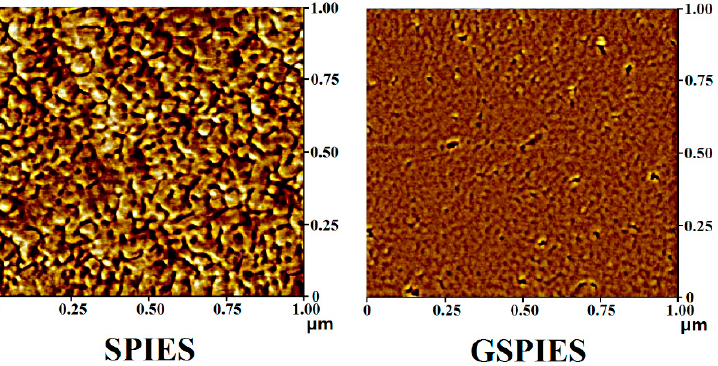
Figure 9. Atomic force microscopy images of SPIES and GSPIES.